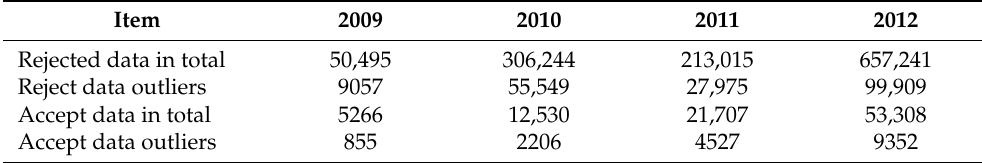
Table 4. The outlier detection